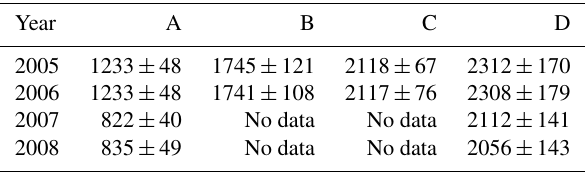
Table 3. Modelled annual forest floor CO 2 effluxes (mean ± SEM; gCO 2 m − 2 a − 1 ) in the four treatments at Kalevansuo peatland. A = peat, B = peat + litter, C = peat + litter + roots and D = peat + litter + roots + ground vegetation . SEM is the standard error between the four plot